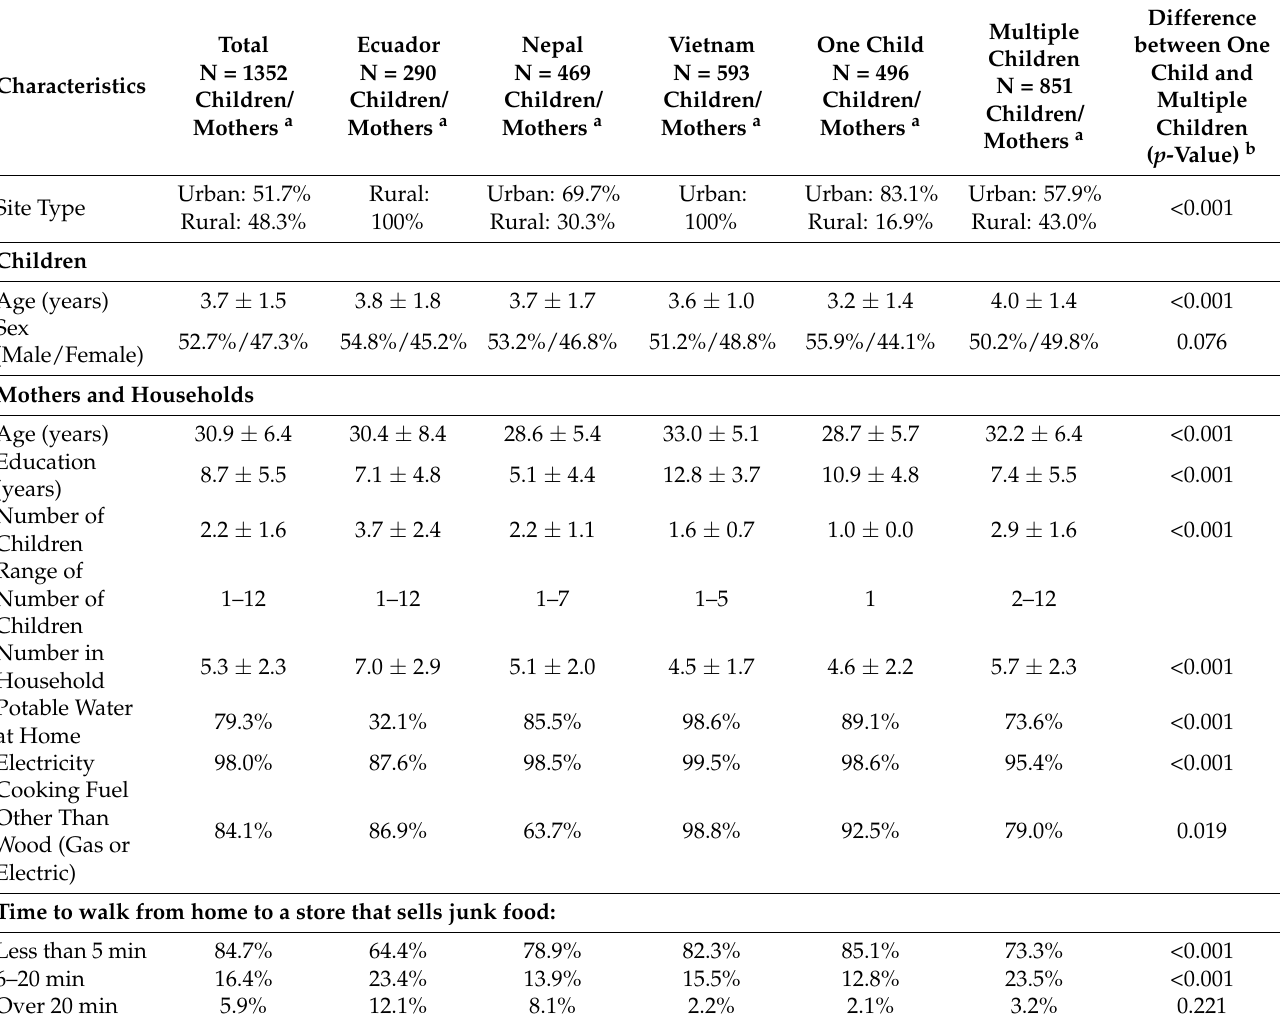
Table 1. Sociodemographic characteristics of children and